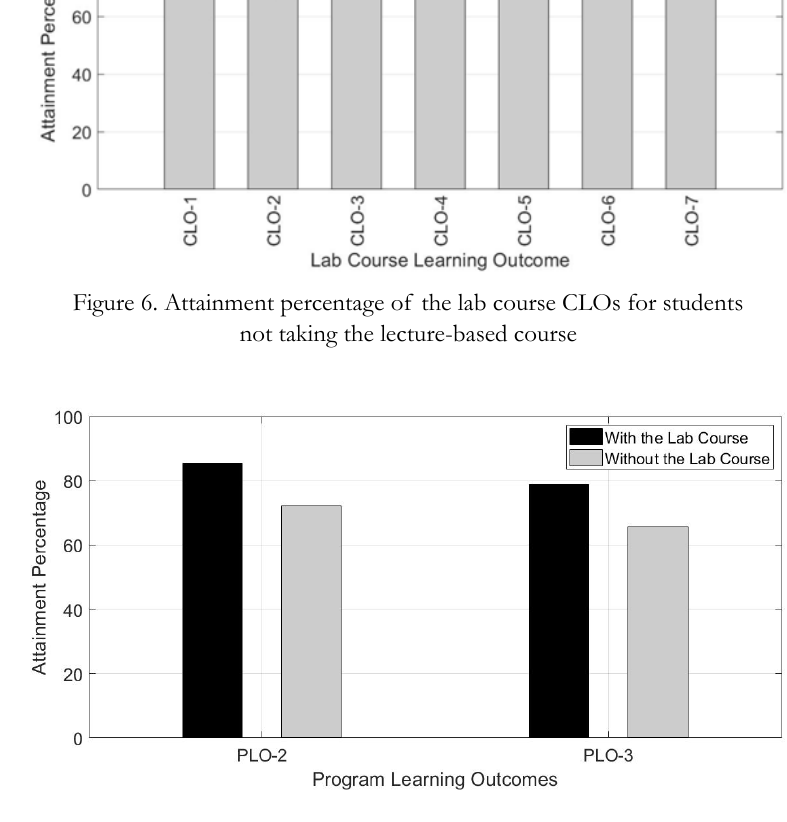
Figure 7. Percentage PLO attainment for the lecture-based